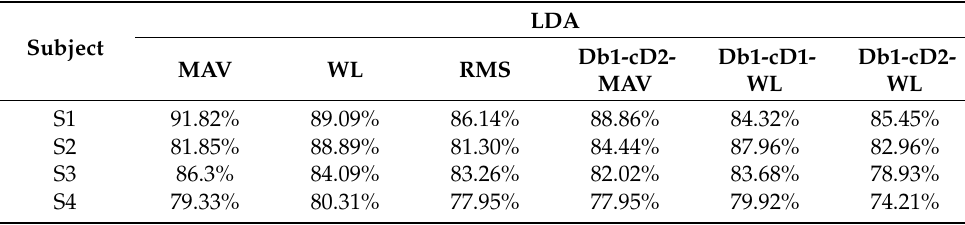
Table 2. Overall classification accuracy of individual sEMG features, LDA classifier.